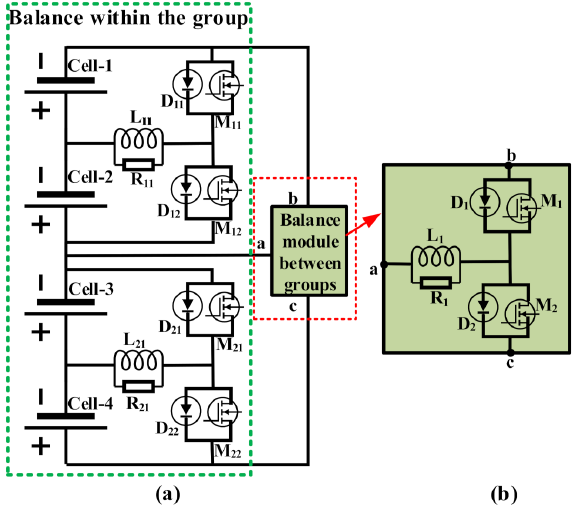
Figure 2. Battery equalization circuit topology. ( a ) Equalization circuit, ( b ) Balance module between groups. By controlling the opening and closing of the MOSFET corresponding to a battery or battery pack with a higher SOC, energy can be transferred from a battery or battery pack with a higher SOC to a nearby battery or battery pack with a lower SOC. It is assumed that SOC Cell-1 > SOC Cell-2 and SOC Cell-3 > SOC Cell-4 for a single cell and SOC pack-1 > SOC pack-2 for a battery pack. The circuit is firstly equalized within the group, that is to say, energy is transferred from high-energy Cell-1 and Cell-3 to low-energy Cell-2 and Cell-4 through inductors L 11 and L 21 . When the circuit in the group reaches equilibrium, the equalization between groups is carried out. Meanwhile, energy will be transferred from the first group of batteries, with high energy, to the second group of batteries, with low energy, via L 1 , until equilibrium is reached. The equalization process can be divided into the following three stages: discharging the battery or battery pack with a higher SOC, charging the battery or battery pack with a lower SOC, and demagnetizing the inductance. The specific working process is revealed in Figure 3.